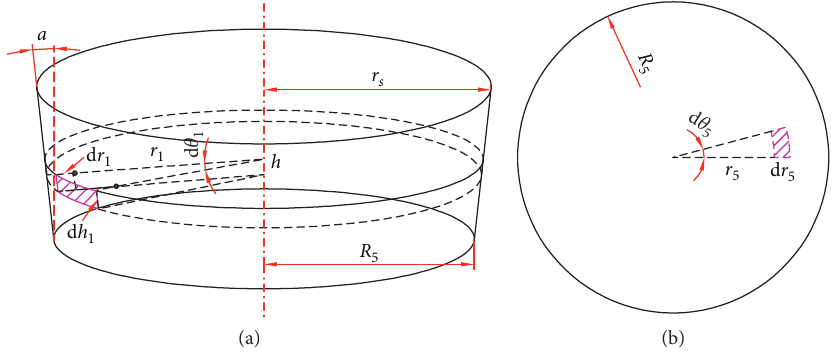
Figure 7: Infinitesimal segment areas from the pin surface in the CAM. (a) Pin side; (b) pin